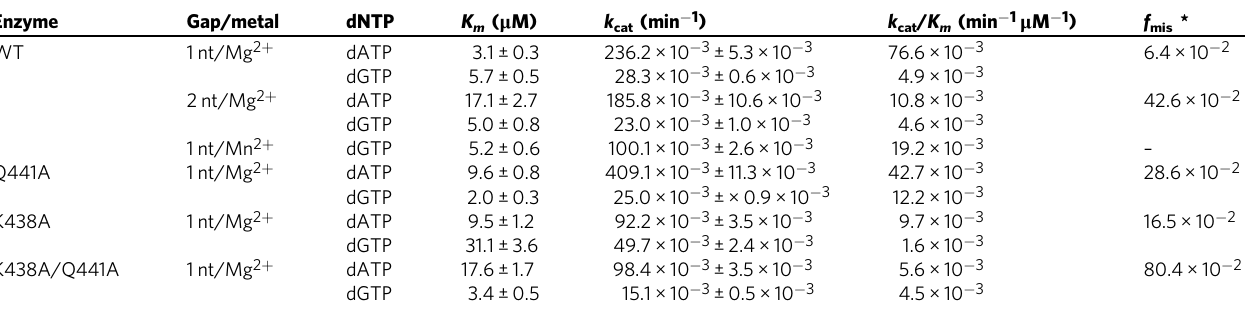
Table 1 Kinetic parameters of dGTP misincorporation opposite gapped DNA containing templating T by pol μ . Enzyme